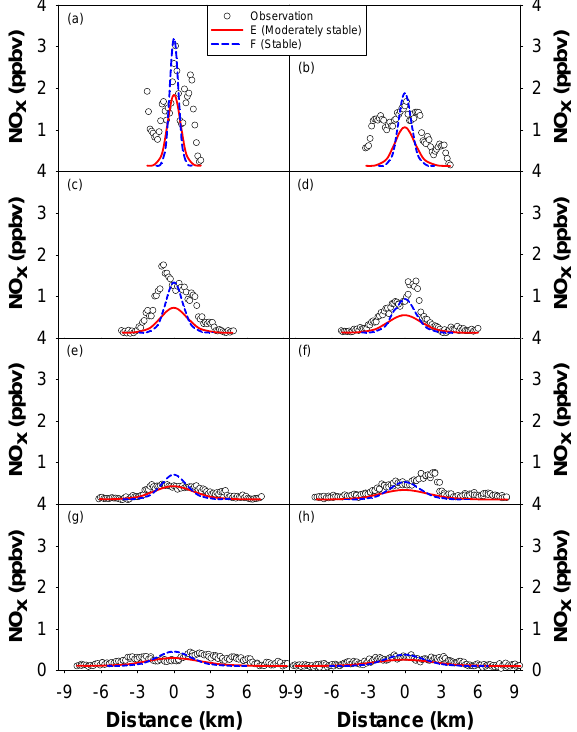
Fig. 4. Model-predicted vs. observed NO x concentrations across the eight ship-plume transects (A-H) under the stability classes of moderately stable (E) and stable (F). Panels (a–h) correspond to the comparison at the ship-plume transects A–H,